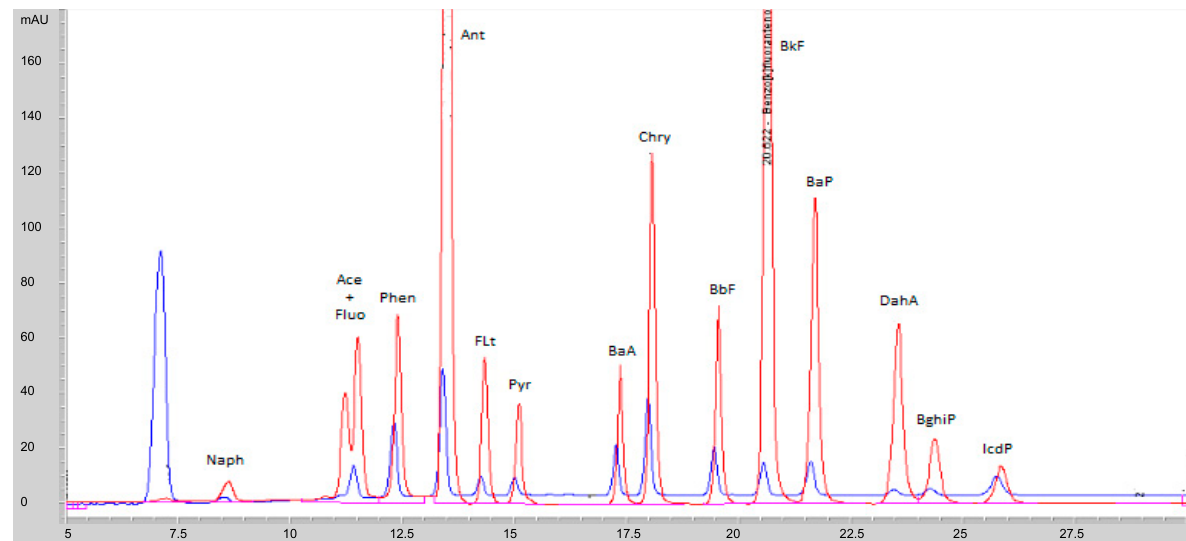
Figure 1. DAD (blue line) and Fl (red line) chromatograms of a PAH mixture solution (Naph, 500 ng/mL; Acy, 1000 ng/mL; Ace, 500 ng/mL; Fluo, 50 ng/mL; Phen, 50 ng/mL; Ant, 50 ng/mL; Flt, 50 ng/mL; Pyr, 50 ng/mL; BaA, 50 ng/mL; Chry, 50 ng/mL; BbF, 50 ng/mL; BkF, 50 ng/mL; BaP, 50 ng/mL; DahA, 100 ng/mL; BghiP, 50 ng/mL; IcdP, 50 ng/mL).